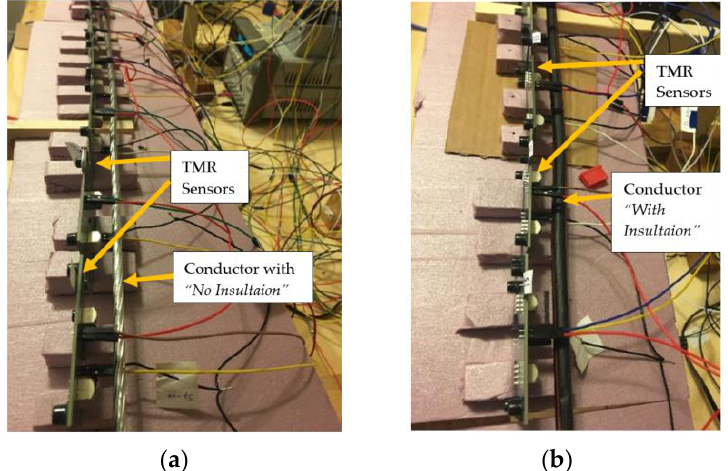
Figure 3. Arrangement of the sensors for ( a ) No-Insulation portion and ( b ) With-Insulation part of the conductor.